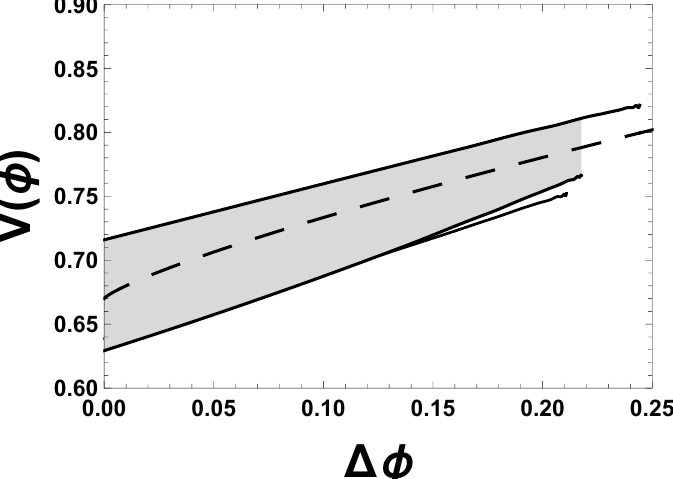
Figure 3. The 2 σ constraint on quintessence thawing potentials. The potential is in the unit of the current critical density ρ cr 0 and ∆ φ is the difference between the scalar field φ and its current value φ 0 . The dashed lines denotes the power-law potential V ( φ ) ∼ φ 0.8